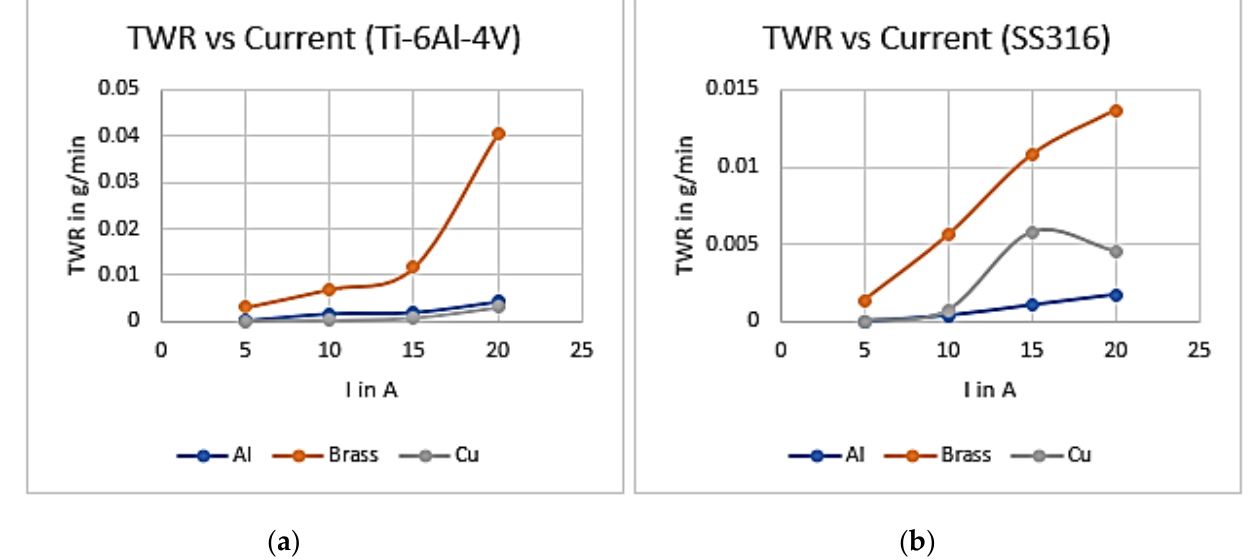
Figure 8. Variations of TWR for ( a ) Ti-6Al-4V and ( b ) SS316 using different tools.